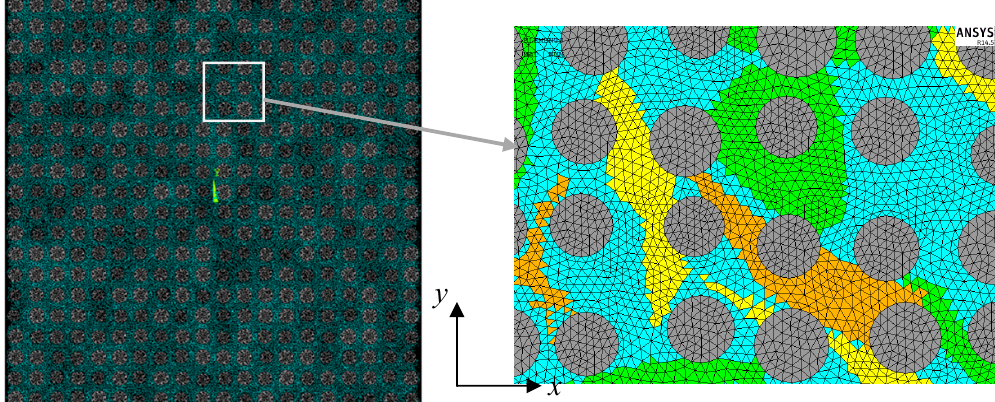
Figure 1. FE mesh of the meso-scale model. The different colors in the elements of the matrix indicate areas with different effective electrical conductivity due to the various density of the CNT network that comes from the micro-scale.